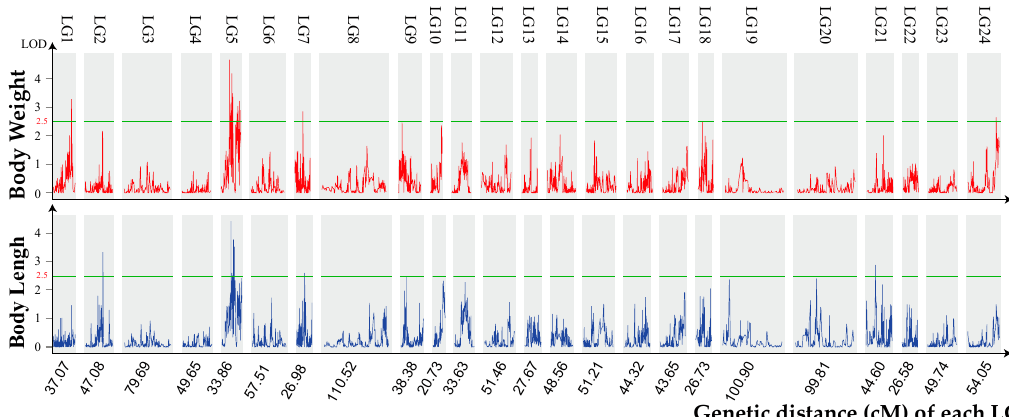
Figure 1. The genetic location of growth-related (body weight and body length) quantitative trait loci (QTLs) on the 24 linkage groups (LGs) of orange-spotted grouper. The green orizontal lines indicate the cutting threshold of logarithm of odds (LOD) at 2.5. The red and blue coloration represents the traits of body weight and body length, respectively.